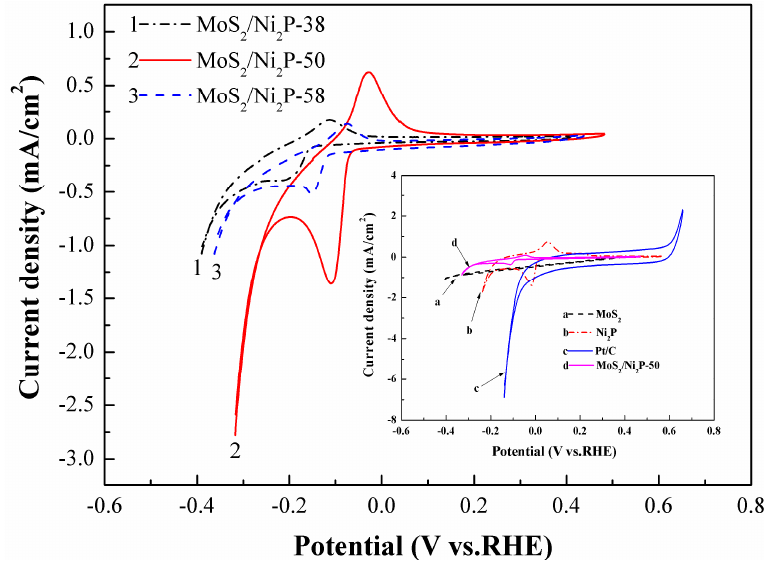
Figure 7. CV curves of pure MoS 2 , Ni 2 P, three MoS 2 /Ni 2 P hybrids and commercial 20 wt % Pt/C. Scan rate: 10 mV/s, potential window: − 0.6~0.8 V (vs. RHE).